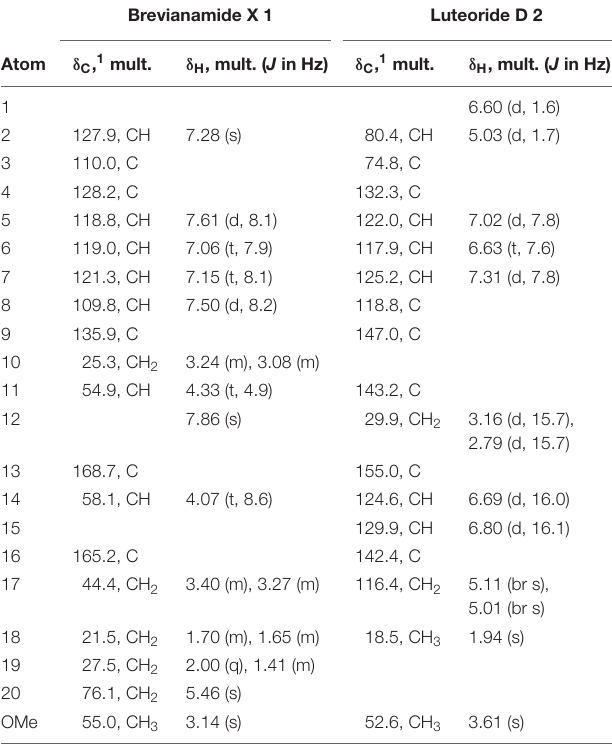
TABLE 1 | Summary of 1 H (600 MHz) and 13 C (150 MHz) NMR spectroscopic data for brevianamide X 1 and luteoride D 2 in DMSO at 298 K. Brevianamide X